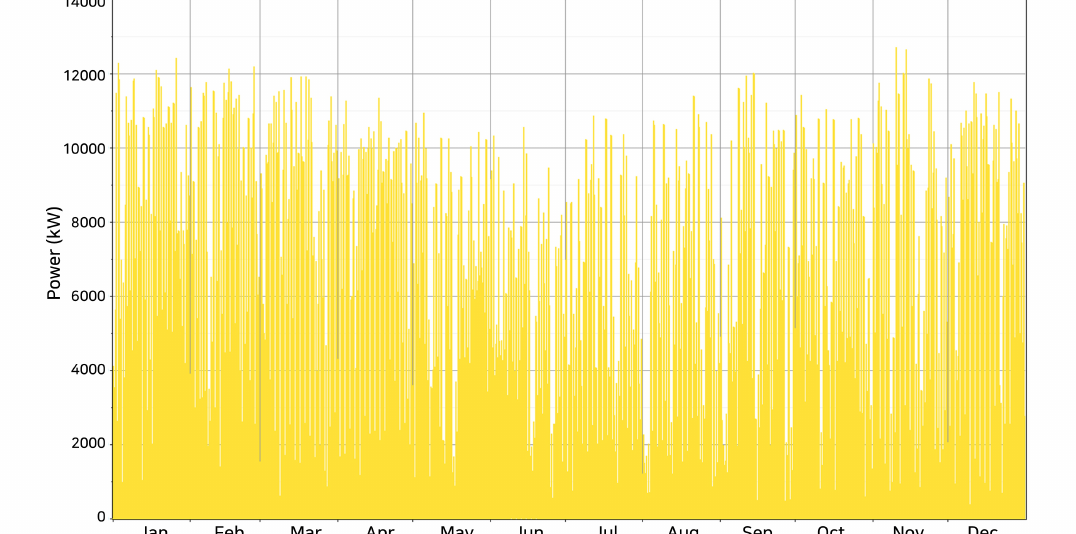
Figure 8. Monthly PV power production of the suggested configuration (created by the